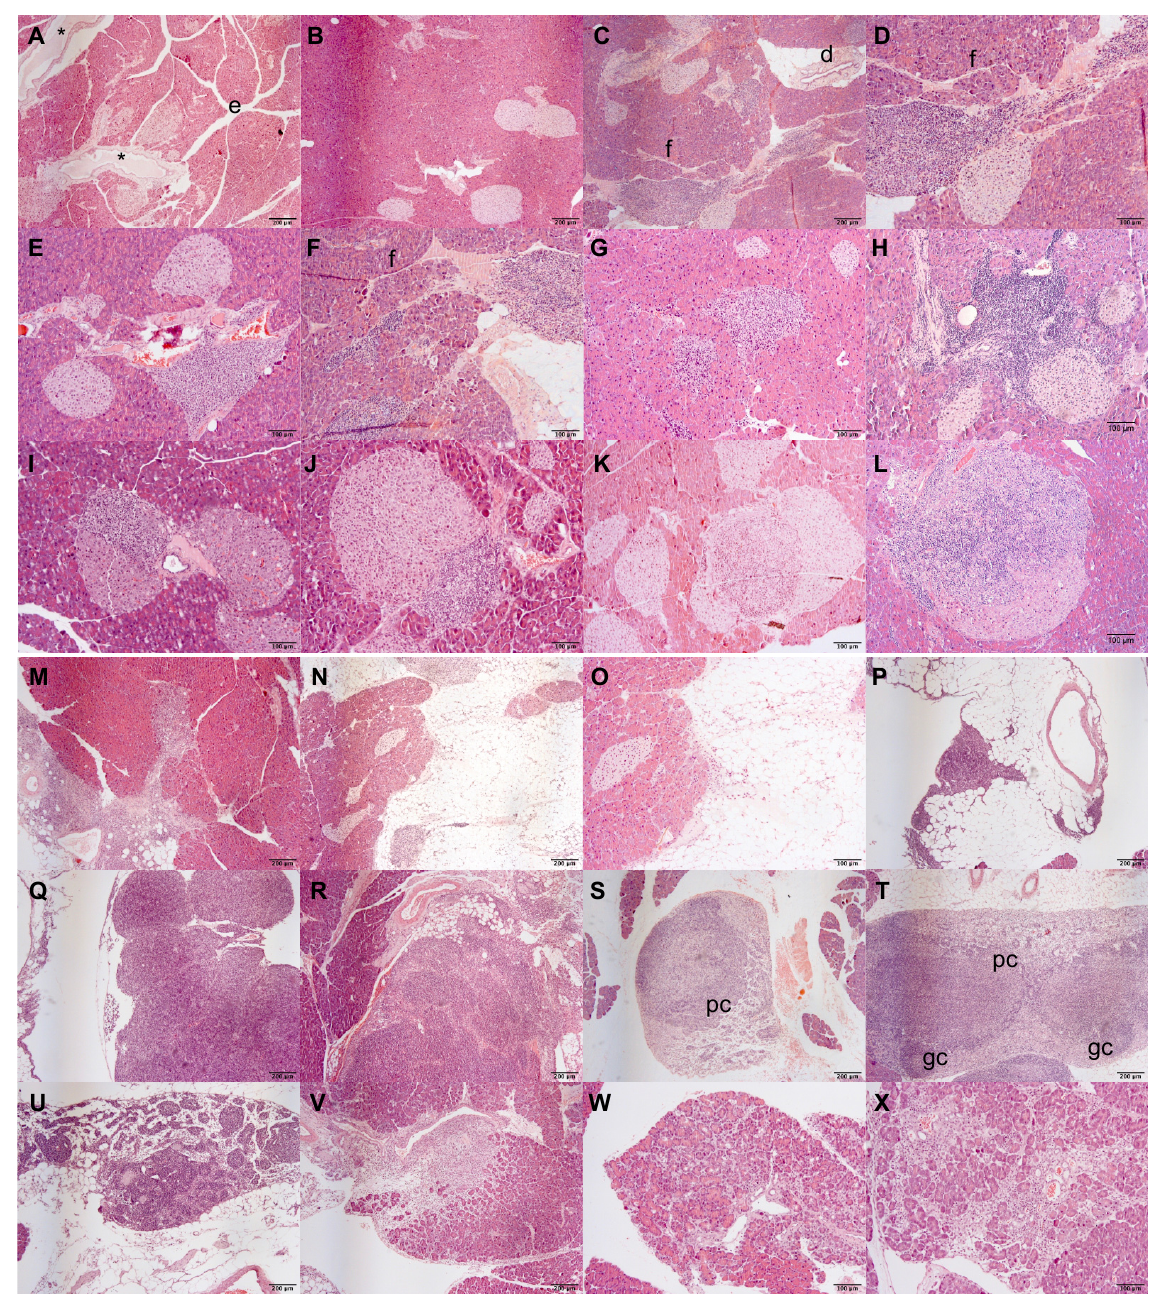
Figure 3. Pancreatic inflammageing lesions. Histopathological evaluation of our aged cohort reveals a prominent role of inflammation in pancreata of Atrx WT and Atrx KO mice. Interlobular oedema ( e ) ( A ), ductal dilation ( * ), loss of lobular pattern ( B ), ductal dysplasia ( d ) and perivascular inflammation ( C , D ), which by continuity is also peri-islet inflammation; also some fibrosis ( f ), perivascular inflammation ( E ), acinar inflammation ( F – H ), intra-islet inflammation and islet hyperplasia ( I – L ), peripancreatic (pp) inflammation ( M – O ), lymphocytes at pp fat invade pancreatic tissue, larger accumulation of lymphocytes in pp fat ( P) , reactive lymph nodes ( Q , R ), paracortical depletion ( pc ) and reduced germinative centres ( gc ) ( S – U ), focal acinar atrophy ( W – X ). Images ( A – C , N , V , W ) are at 40× magnification; remaining images are at 100×.